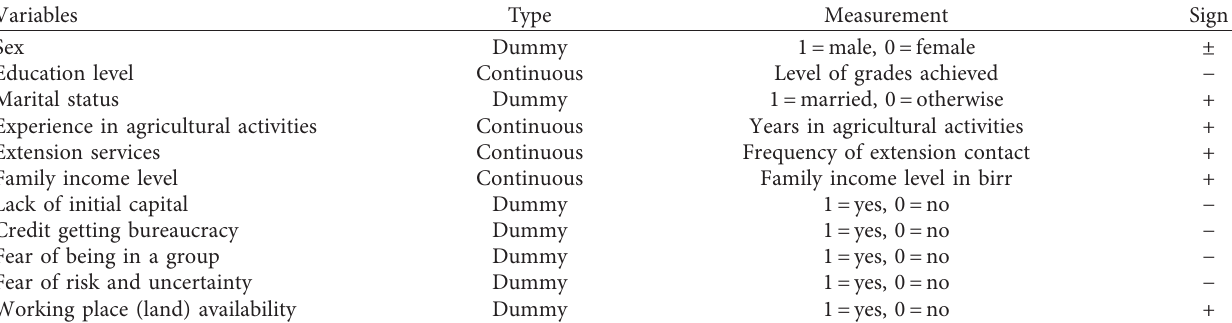
Table 1: The hypothesized variables used for econometric analysis and their expected sign.